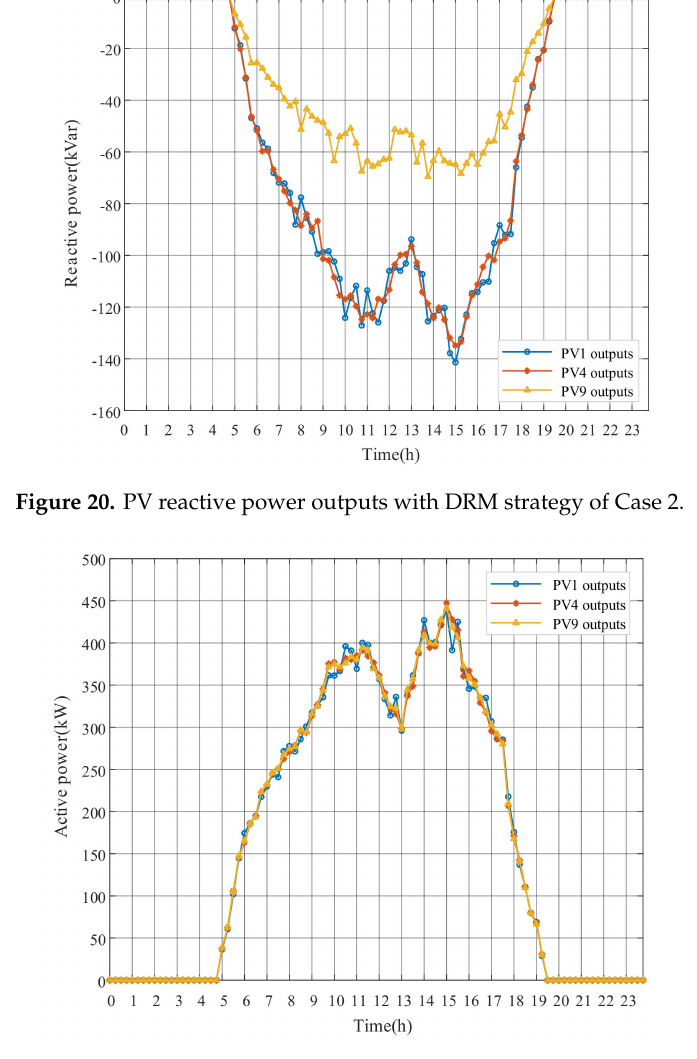
Figure 21. PV active power outputs with DRM strategy of Case